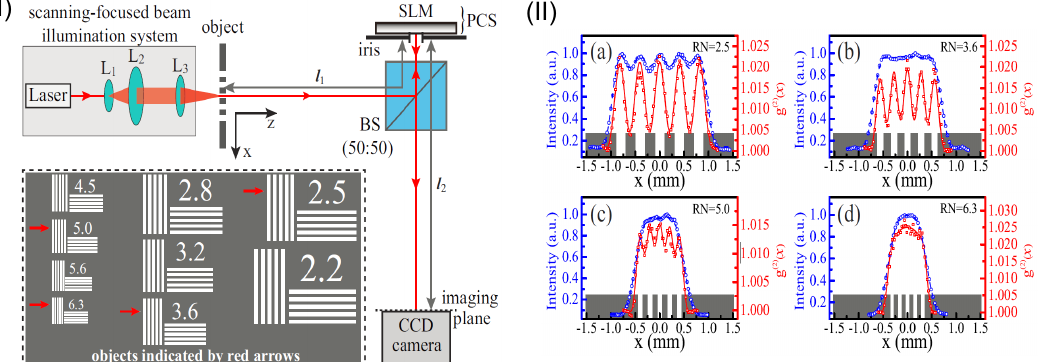
Figure 11. ( I ): Schematic of experimental setup for realizing Heisenberg-resolution imaging with scanning focused-beam illumination. The phase-controlled screen (PCS) is realized by a phase-only spatial light modulator. The objects to be imaged are shown in the inset, indicated by the red arrows; ( II ): The HL super-resolution images (red circles) for different objects. The super-resolution effect is demonstrated by comparing with the conventional intensity images (blue circles). Please note that the object with a RN = 5.0 is with slit separation beyond the SQL. The figure is reproduced with permissions from Ref. [43] of